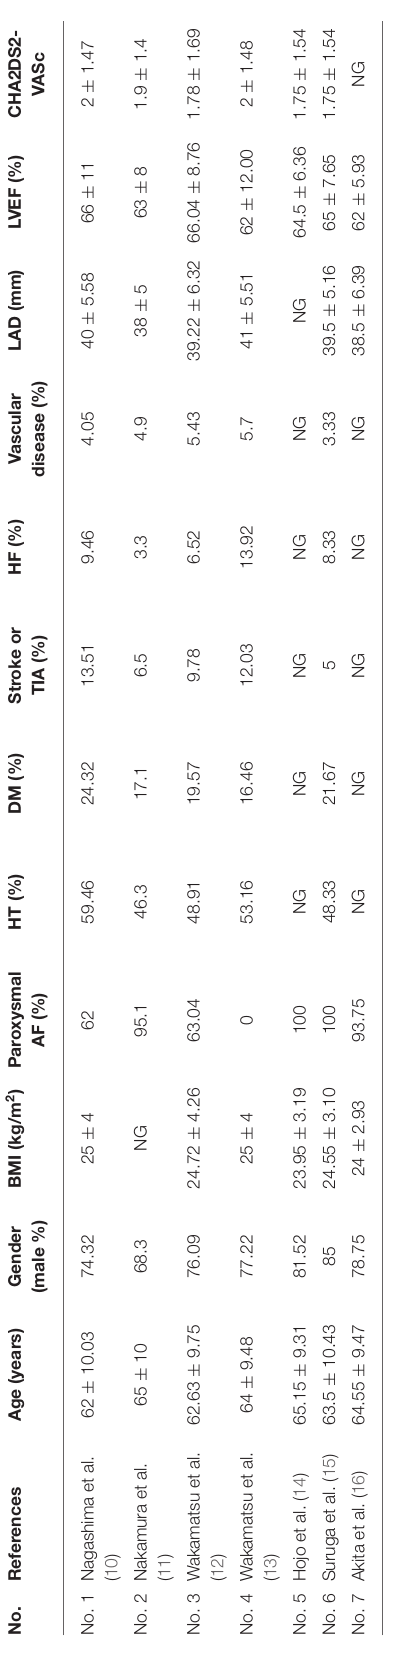
Figure 6 ; among the 4 PVs, the left superior and right superior PVs are more likely to be agitated with a higher volume of